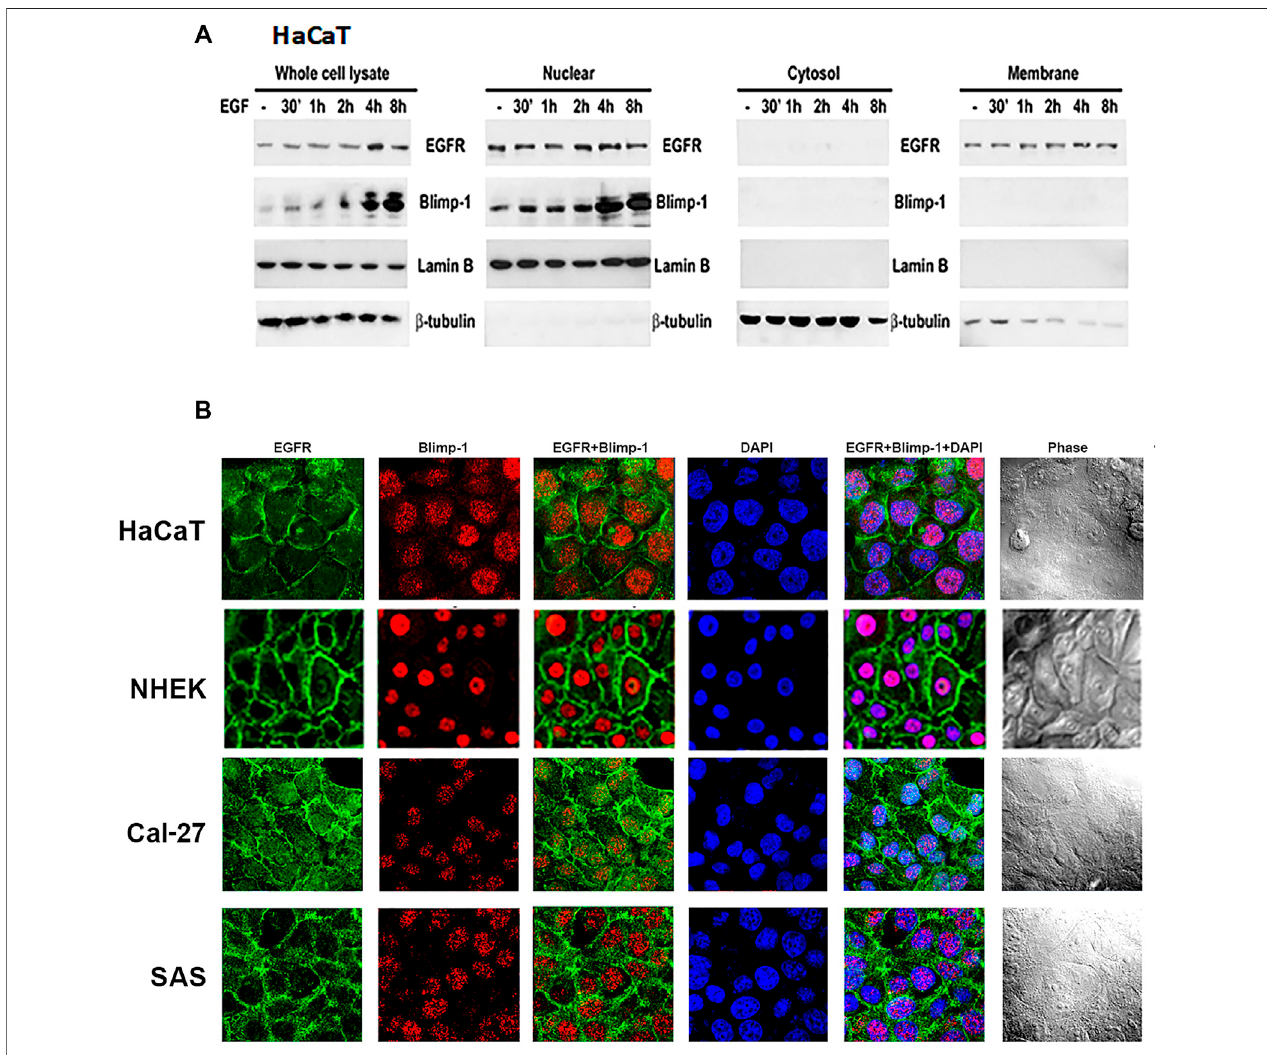
FIGURE 4 | Intracellular localization of Blimp-1 in keratinocytes and SCC. (A) Total cell lysates of EGF-stimulated HaCaT cells were separated into cytosol, membrane and nuclear fractions. Protein levels of Blimp-1, EGFR, lamin B and β -tubulin were determined. Lamin B and β -tubulin were the nuclear and cytosol markers, respectively. Data were representative from three independent experiments. (B) HaCaT cells, NHEKs, Cal-27, and SAS cells were seeded in 12-well plates. Immuno fl uorescence staining was performed to detect EGFR and Blimp-1 expression. Nuclei were counterstained with DAPI (blue color).